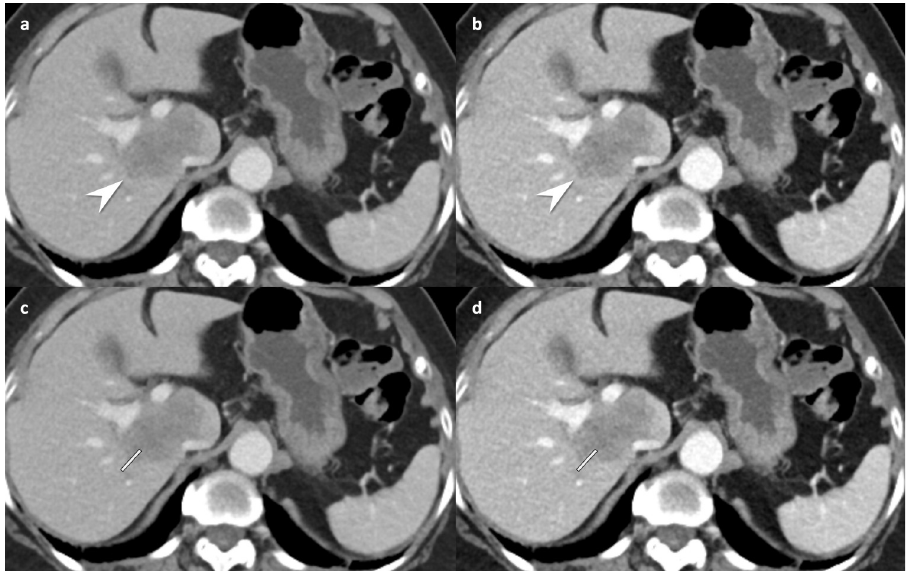
Fig 3. Contrast-enhanced abdomen CT in portal venous phase in a 37-year-old woman (body mass index, 29.0 kg/ m 2 ) with ascending colon cancer and liver metastasis. 80/Sn150 kVp CT (a, effective dose; 5.9 mSv) shows a liver metastasis in the right hepatic lobe/segment 1 (white arrowhead) by each reader (reader 1 and reader 2, grade 4 lesion conspicuity, grade 5 diagnostic confidence, and grade 5 overall image quality). The corresponding image obtained during the same contrast-enhanced phase with 80 kVp CT (b, effective dose; 3.4 mSv) demonstrates increased conspicuity of the lesion by each reader (white arrowhead, reader 1 and reader 2, grade 5 lesion conspicuity, grade 5 diagnostic confidence, and grade 5 overall image quality). Modified line-density profile revealed higher attenuation differences between the tumor and the normal tissue at 80 kVp (d) than those at 80/Sn150 CT (c) (maximum HU: minimum HU, 157:52 vs.129:49). CT, computed